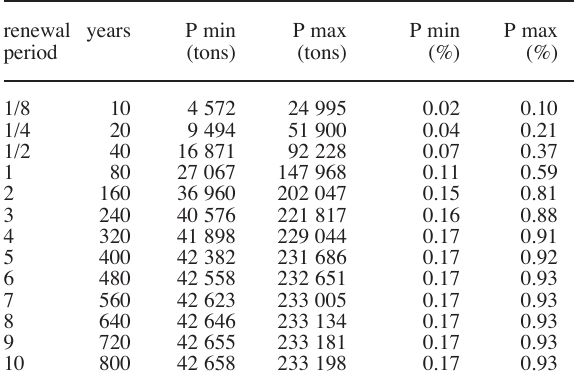
T ABLE 3. – Accumulation of P discharged from fish farming in the Mediterranean for different temporal scales corresponding to pro- portions of the Mediterranean water renewal period (80 years). Minimal and maximal estimates are given for production of 150000 tons in total quantities and as a percentage of the present total P